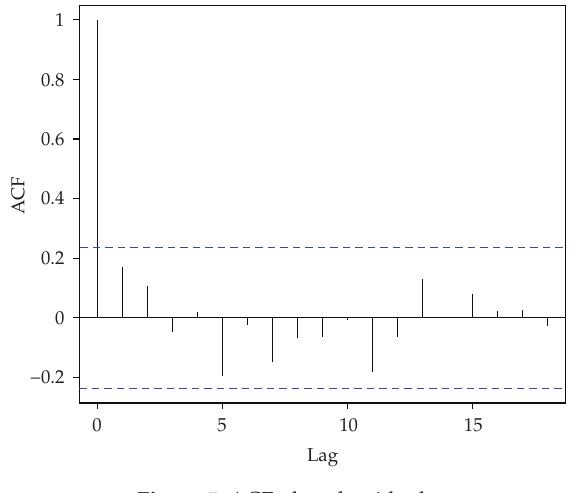
Figure 5: ACF plot of residuals.